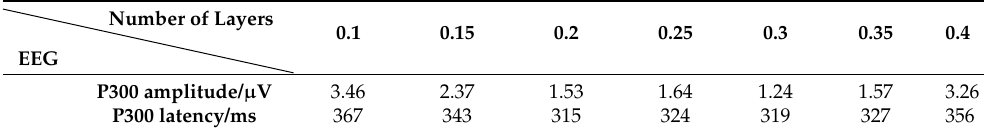
Table 19. The average value of the EEG data for different relative positions of the information display layer.